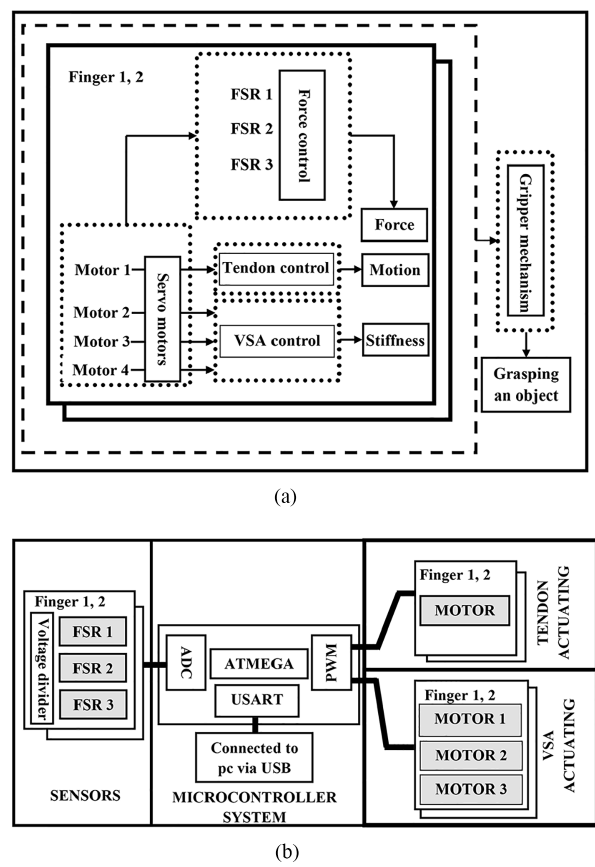
Figure 10. The prototype of robot hand (a) 3-D CAD drawing